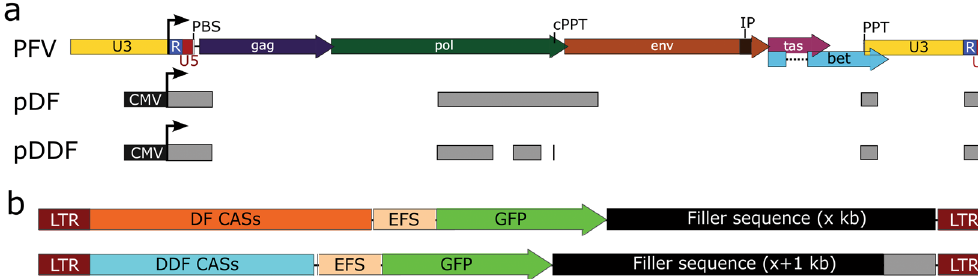
Figure 1. Vector designs to determine effect of size on titre. ( a ) Alignment of the PFV provirus sequence to the transfer plasmids pDF or pDDF. ( b ) Strategy to determine the effect of size on titre. Filler sequence added in increasing increments of 1 kb are controlled for by the difference in size between the CIS-acting sequences (CASs) of DF (top) and DDF (bottom). Arrows indicate the transcriptional start site for genomic RNAs. PBS - primer binding site. cPPT - central polypurine tract. IP - internal promoter. PPT - polypurine tract. CMV - cytomegalovirus promoter. LTR - long terminal repeat. EFS - elongation factor 1 α short promoter. GFP - enhanced green fluorescent protein.